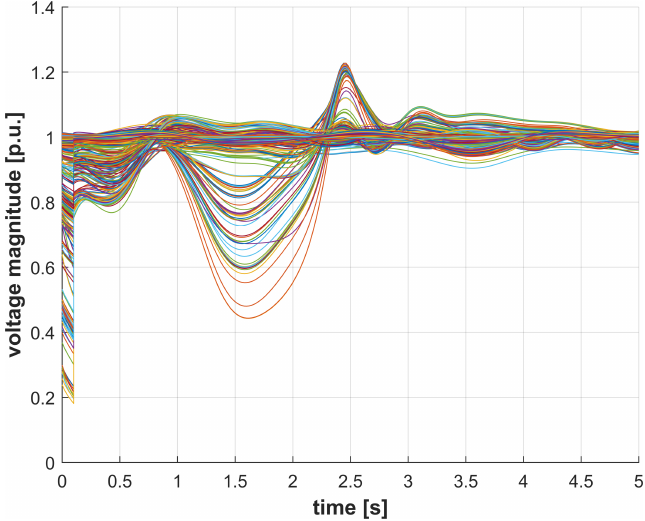
Figure 15. Rotor angles with a “single-shot” 5s window D-FACTS control.